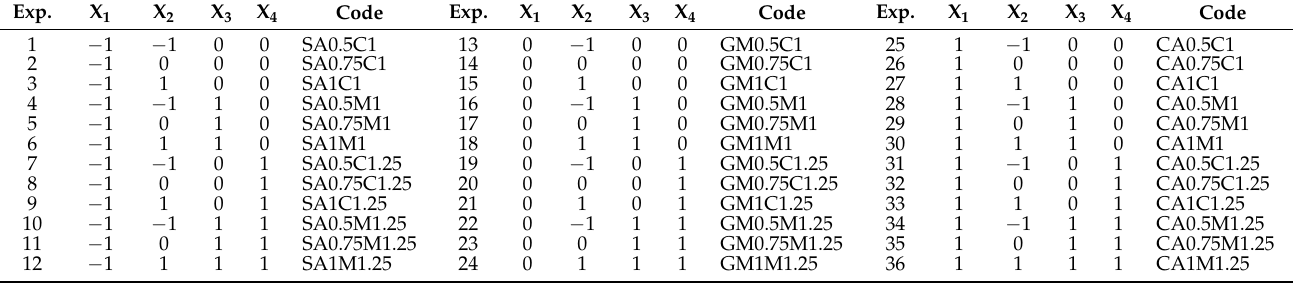
Table 1. Factorial design of independent variables X 1 (lipid base) and X 3 (filler), and dependent variables X 2 (lipid:drug ratio) and X 4 (magnesium stearate concentration), assessed during lipid matrix tablet